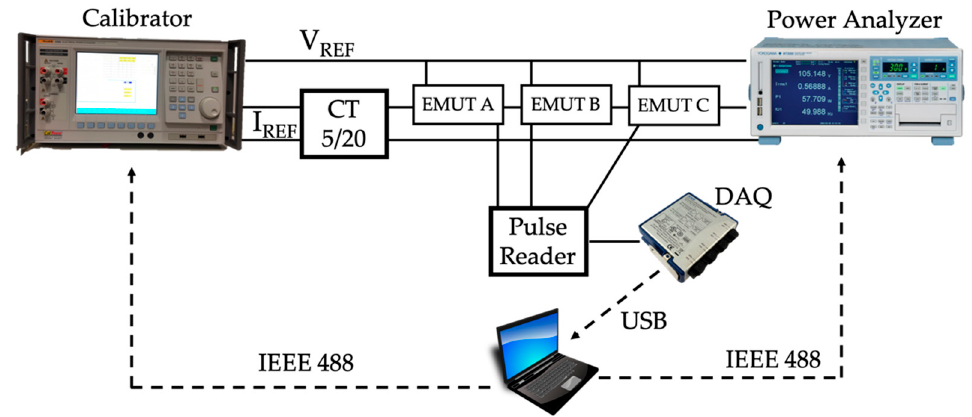
Figure 3. Adopted measurement setup for testing the 3 off-the-shelf energy meters (Ems).